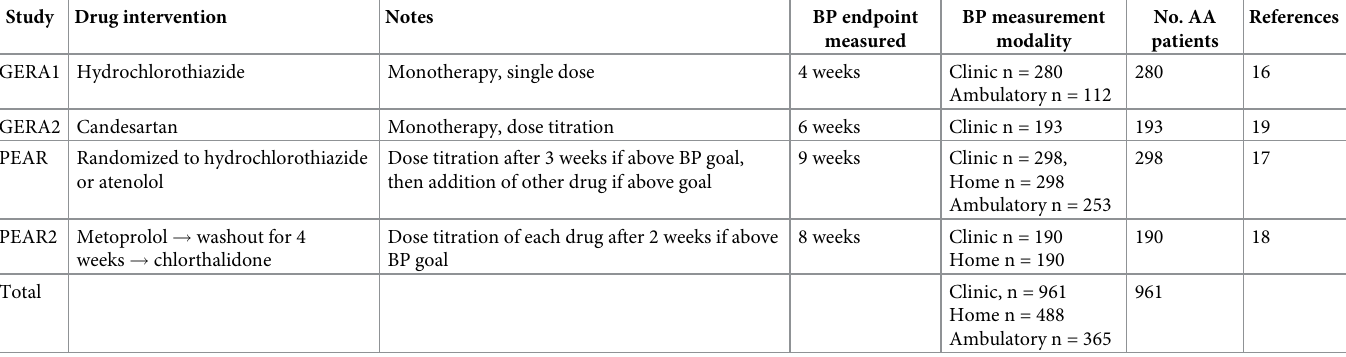
Table 1. Combined studies used in this